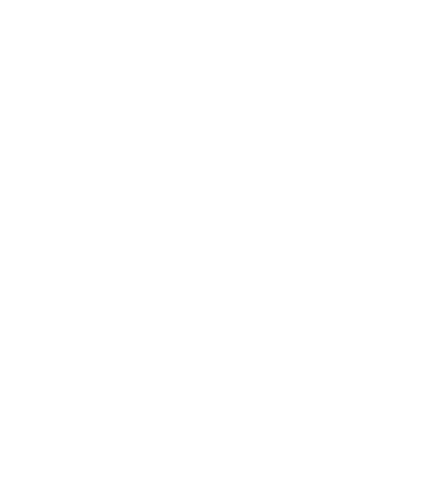
Figure 13. Kidney stones segmentation predictions success rate of segmentation networks trained